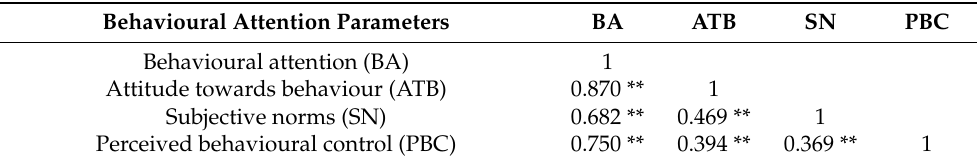
Table 3. Correlation between attitude towards behaviour, subjective norms, perceived behavioural control and the total behavioural attention scales ( n = 385).